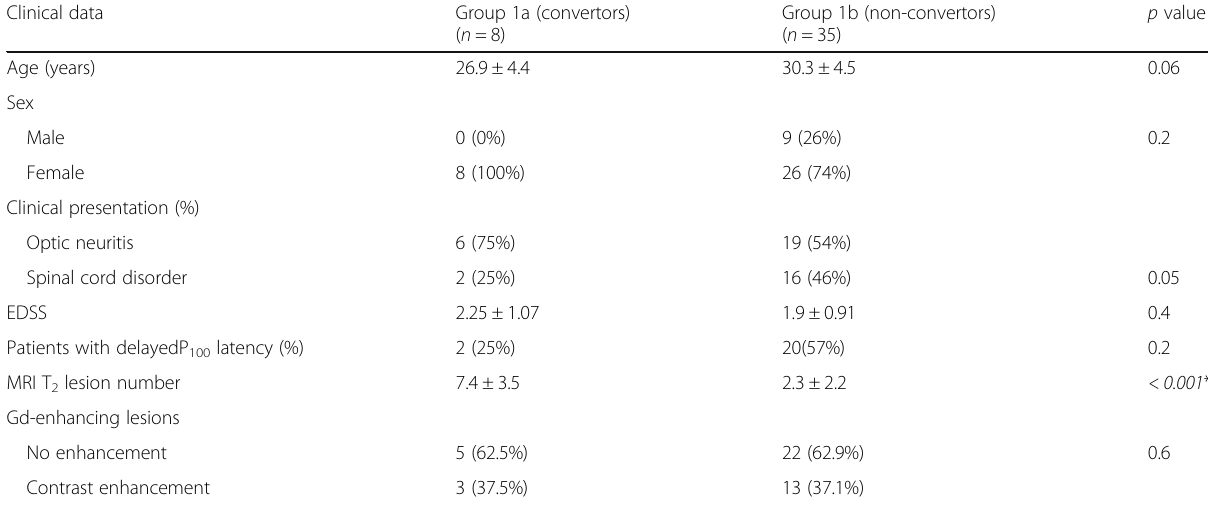
Table 1 Comparison between the convertors and non-convertors at baseline of the study as regard clinical, radiological, and neurophysiological data Clinical data